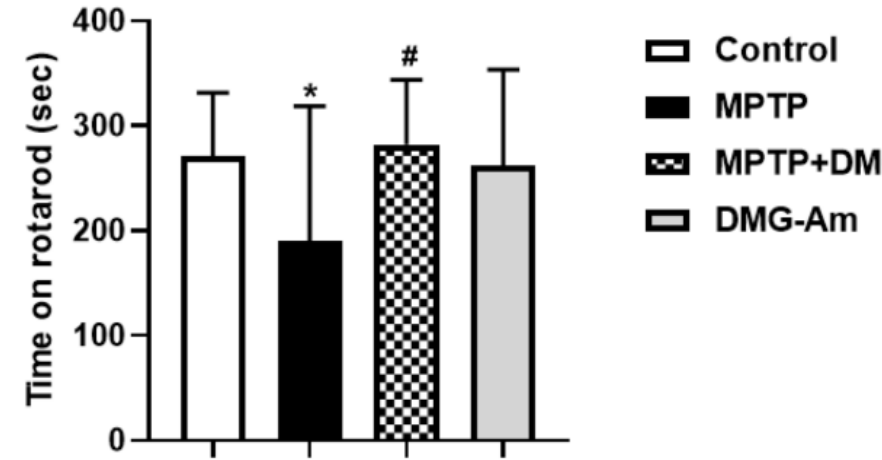
Figure 7. Effect of DMG-Am on neuromuscular coordination. Asterisks above bars indicate significant differences in number of falls per minute for each experimental group versus control at * p < 0.05. Hashtags above bars indicate significant difference in number of falls per minute versus the MPTP-treated group at # p < 0.05. Statistical analysis was performed by one-way analysis of variance (ANOVA) followed by Dunnett’s post hoc comparison test.